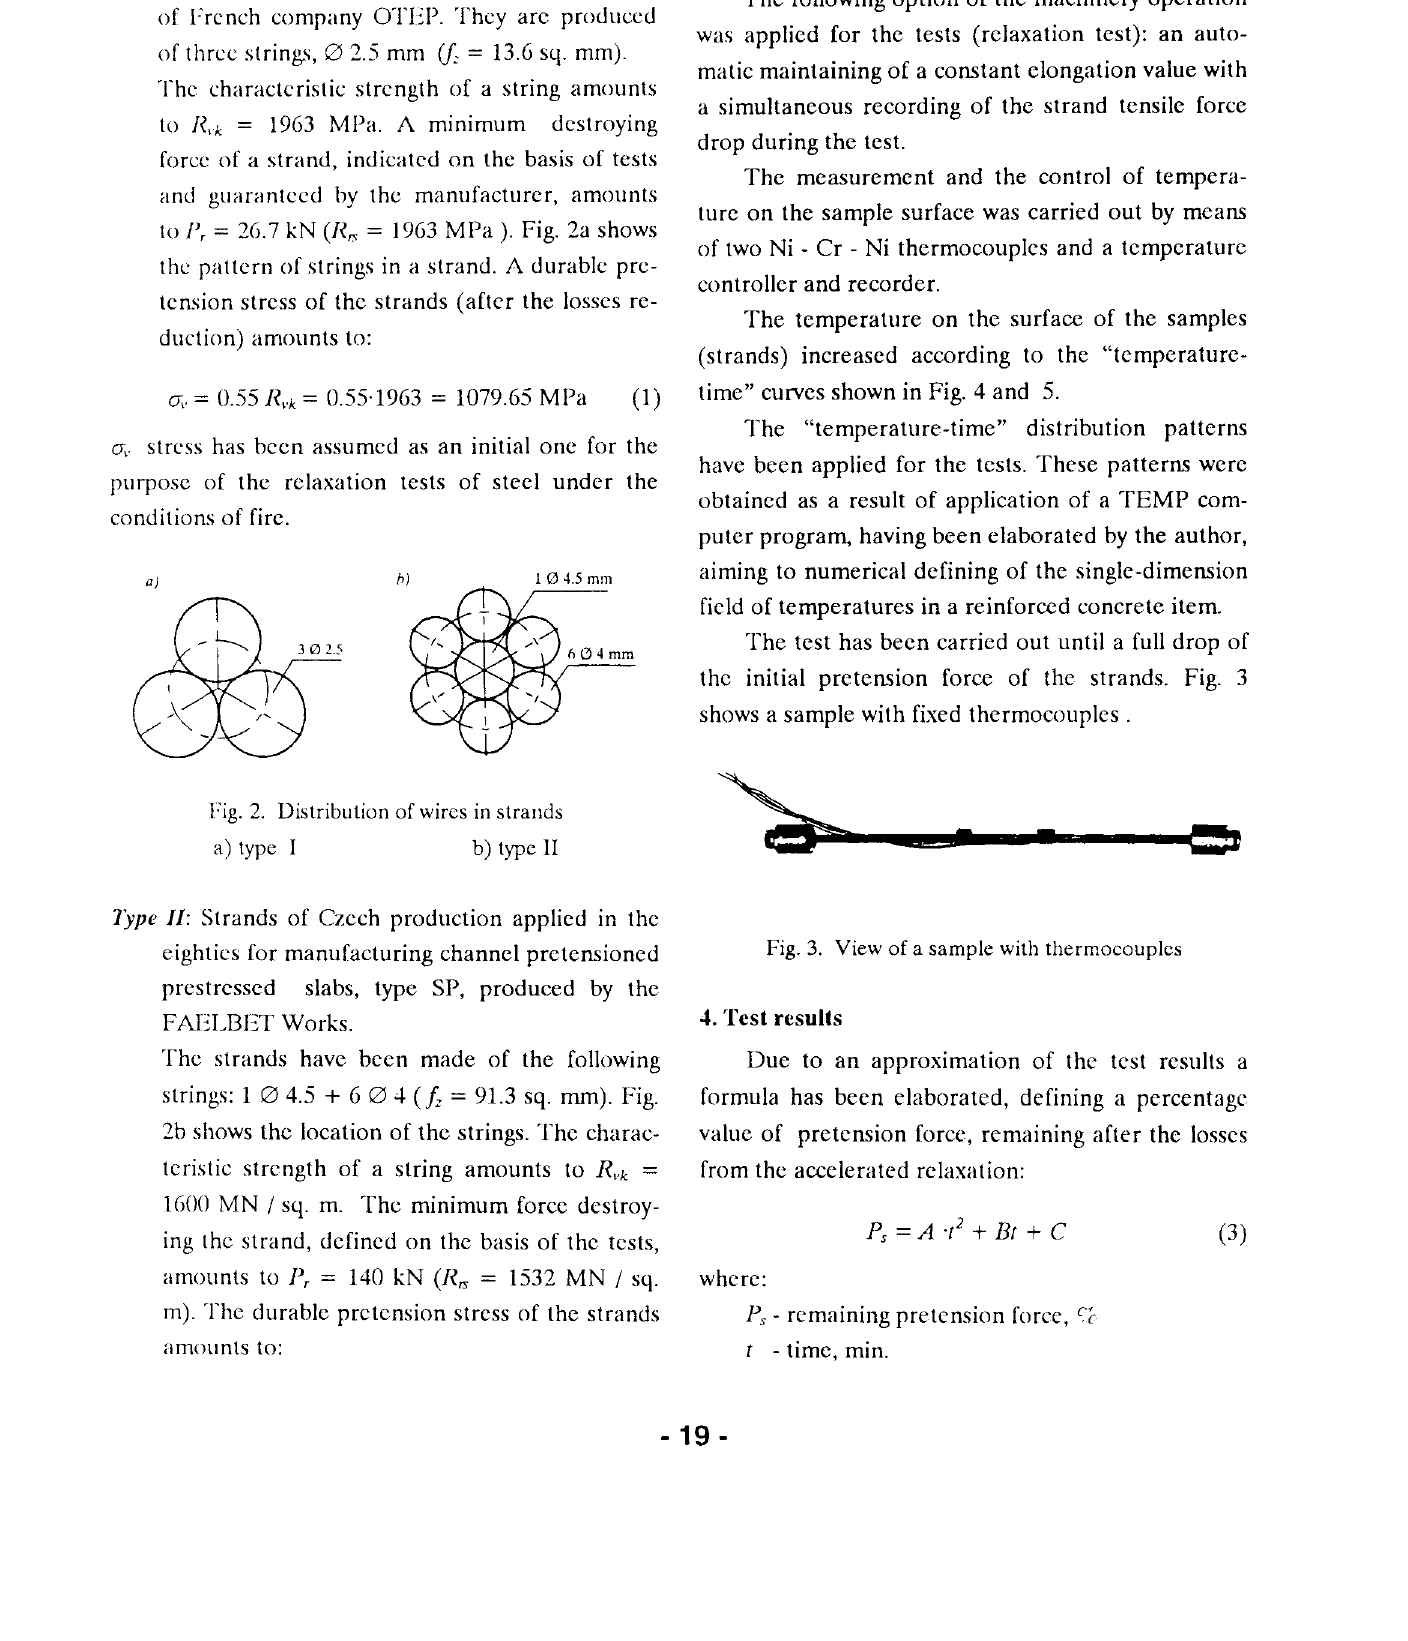
Fig. 2. Distribution of wires in strands